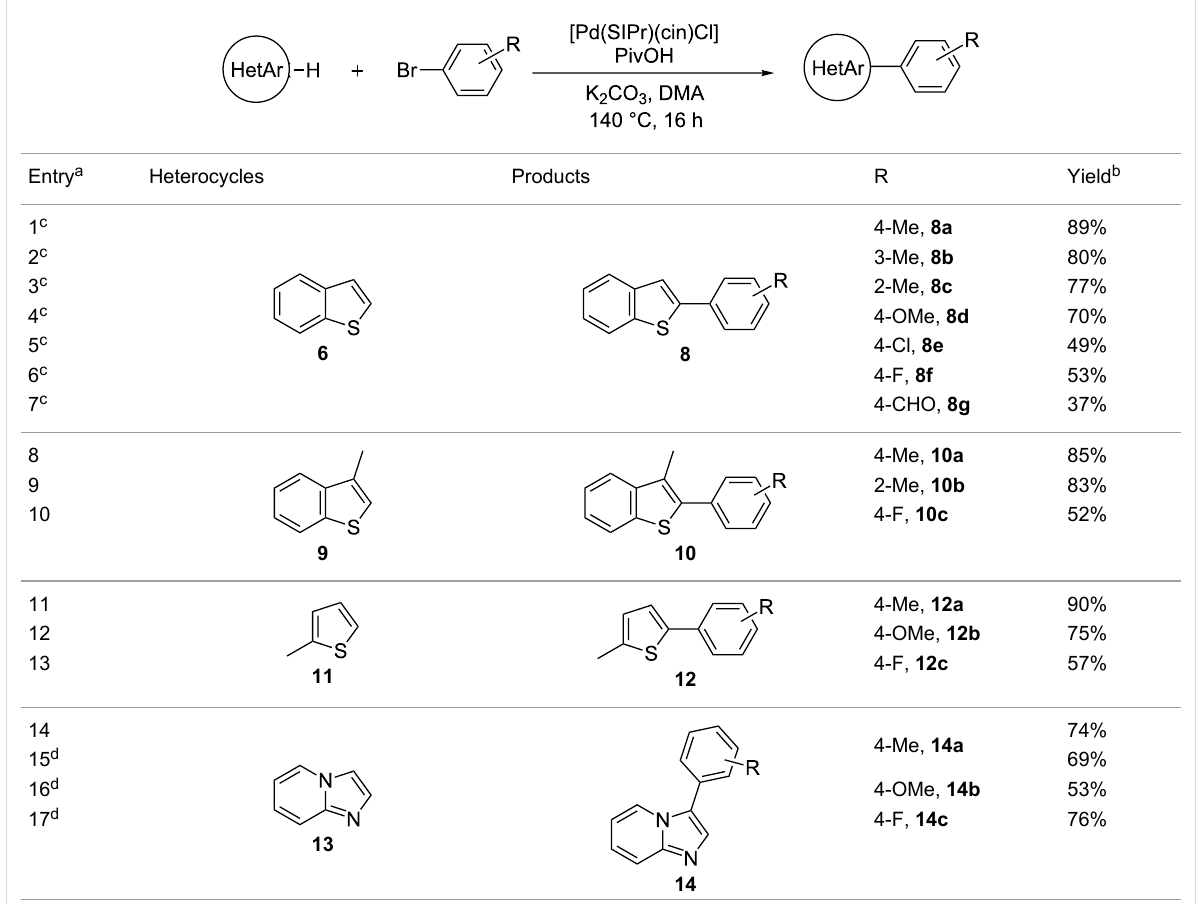
Table 3: Catalyst screening under optimised conditions. Table 4: Palladium-NHC catalysed direct arylation of heterocycles with arylbromides.